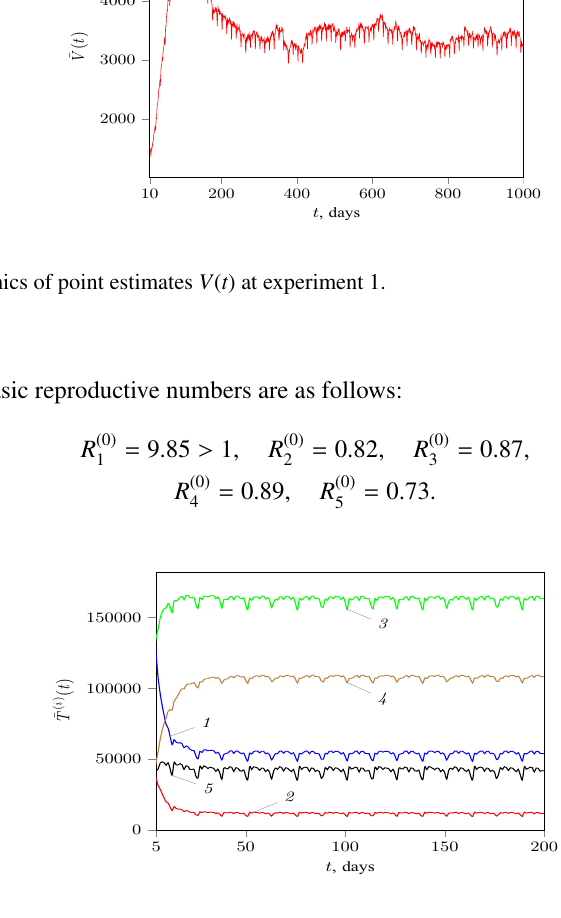
1 Figure 7. Dynamics of point estimates T ( i ) ( t ) without HIV-1 infection at experiment 2.